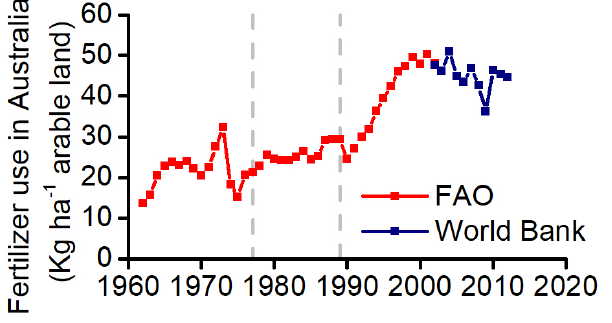
Fig. 6 . Trends in fertilizer use (nitrogen and phosphorus) in Australia (FAO 2014, World Bank 2014) from 1962 through 2012. Vertical dashed lines indicate the period during which groundwaters entering Ewens Ponds recharged the aquifer, based on the results of groundwater dating in this